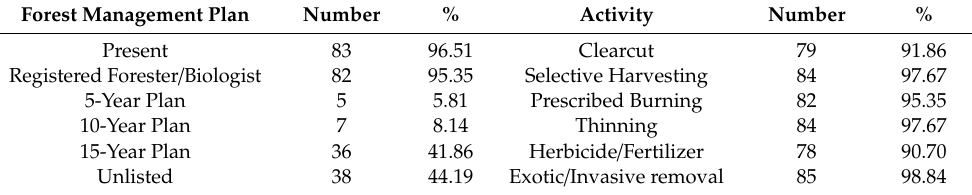
Table 4. Characteristics of forest management activity based on 86 WFCEs in